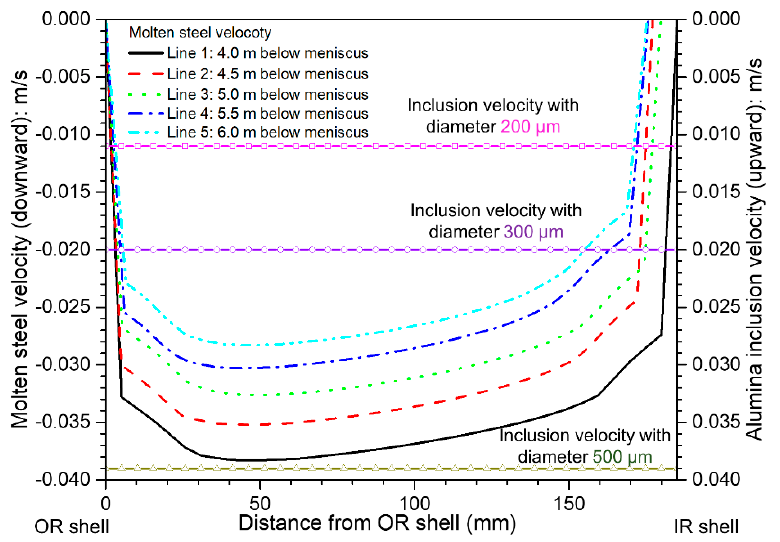
Figure 18. Comparison of molten steel velocity profiles through the strand thickness at the w/8 plane in the strand region 4–6 m below the meniscus with the terminal ascending velocity of three large inclusion sizes.